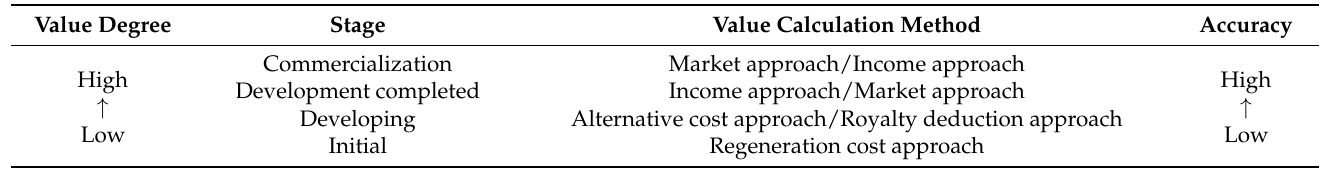
Table 3. Calculation of value based on technological